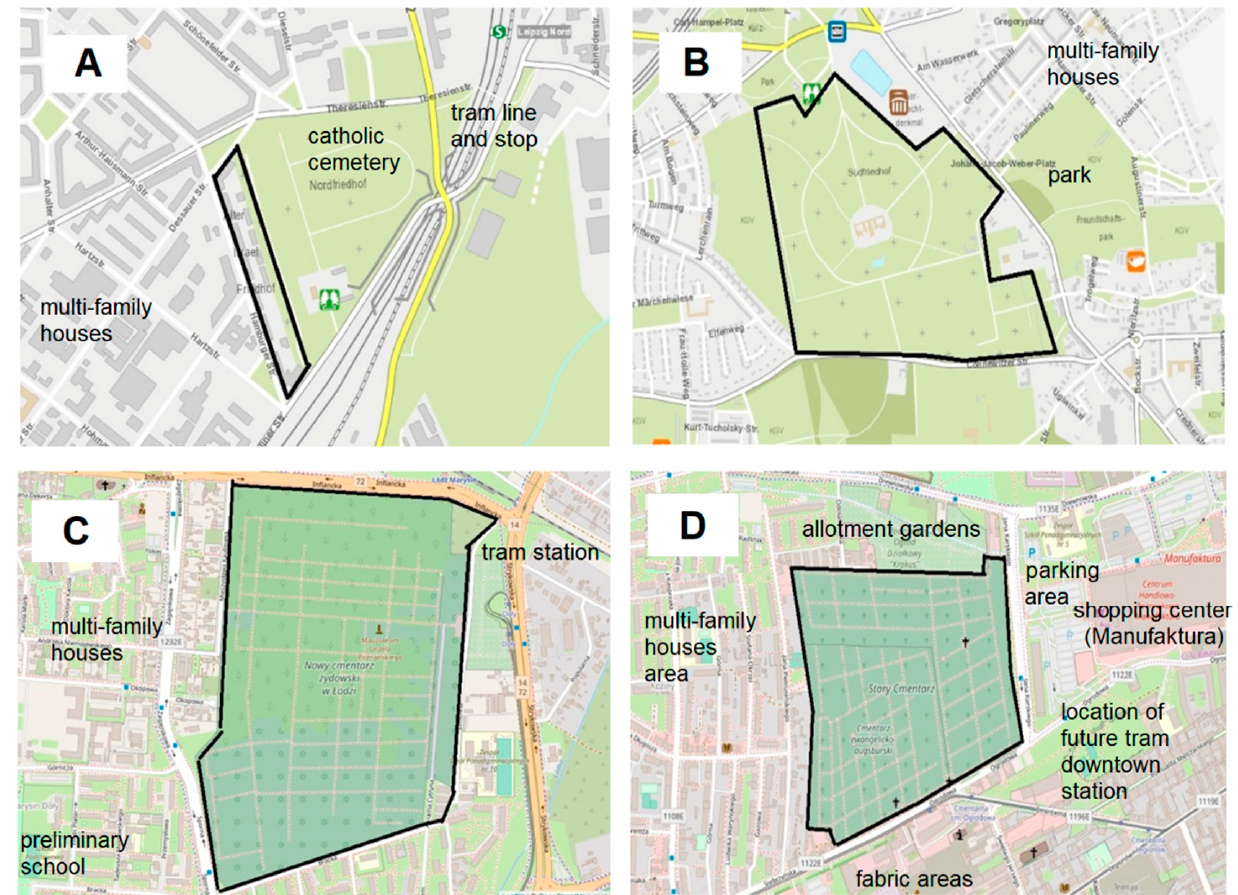
Figure 3. Maps with location of case studies (black line—boundary of given cemetery) with neigh ‐